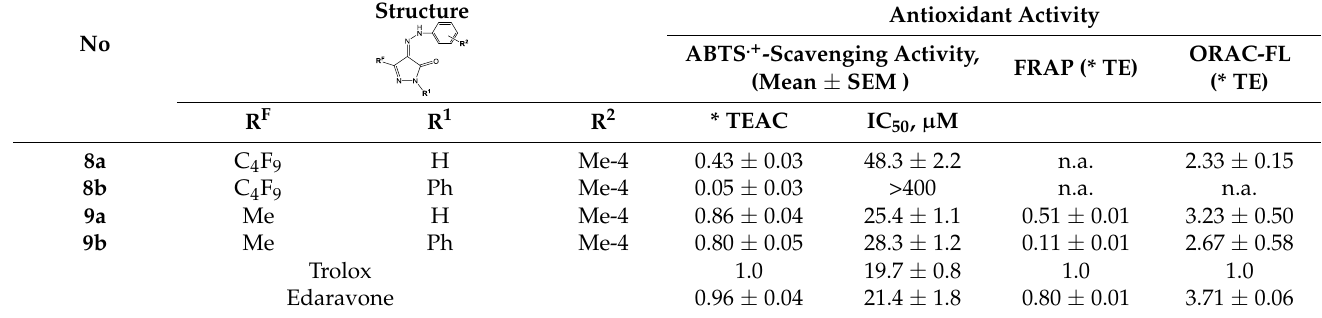
Table 5. Cont. Table 5. Antioxidant activity of 4-AHPs 5 –